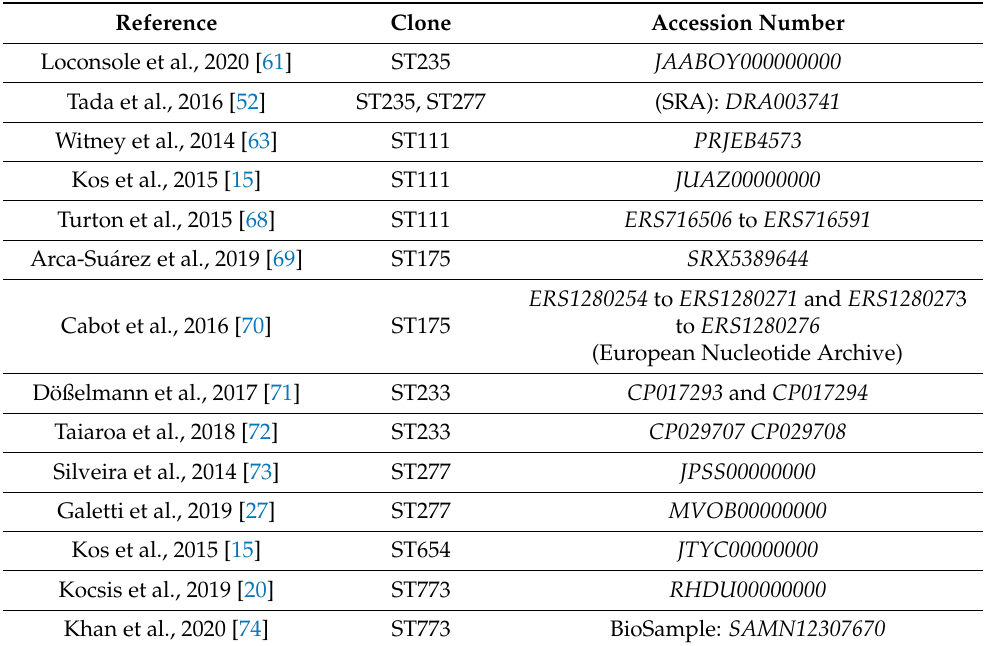
Table 1. Whole genome sequences of high-risk P. aeruginosa clones from published